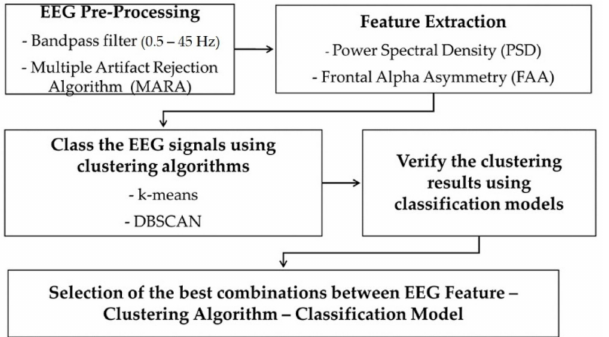
Figure 1. Suggestion scheme to cluster the situational interest automatically during classroom